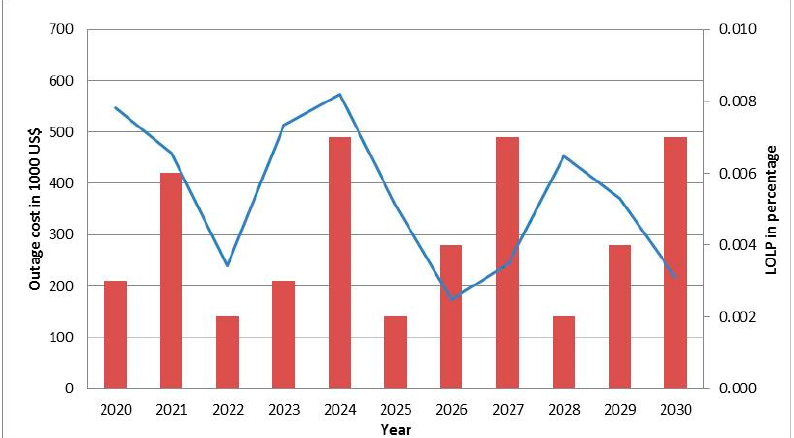
Figure 10. LOLP and OC in a scenario with LOLP = 0.01% and VOLL $10 USD/kWh.